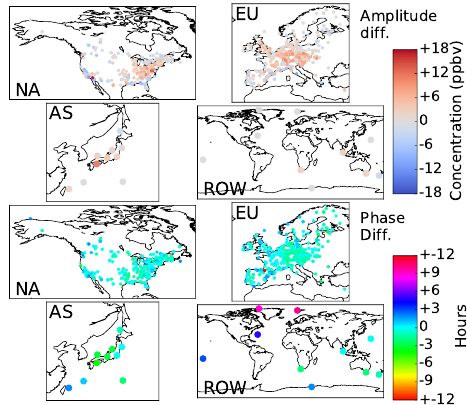
Figure 11. Seasonal amplitude (upper panel) and phase (lower panel) differences between observations and the GEOS-Chem model. NA is North America, EU is Europe, AS is Asia, and ROW is rest of world.